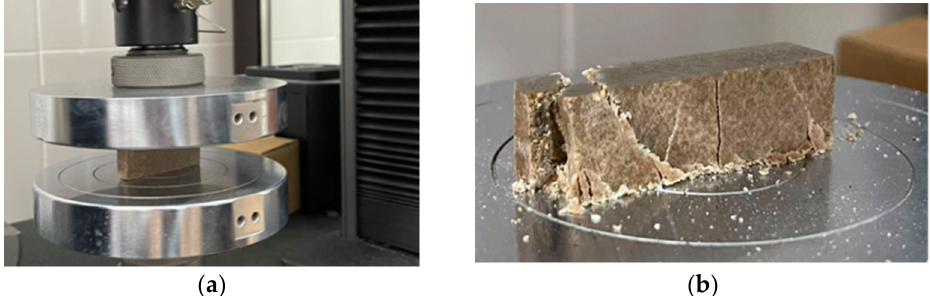
Figure 13. The experiment results: ( a ) Compression experiment process on the Universal Testing System INSTRON 5980; ( b ) the result of the experiment (destruction of the sample at an axial force of 93.94 kN).